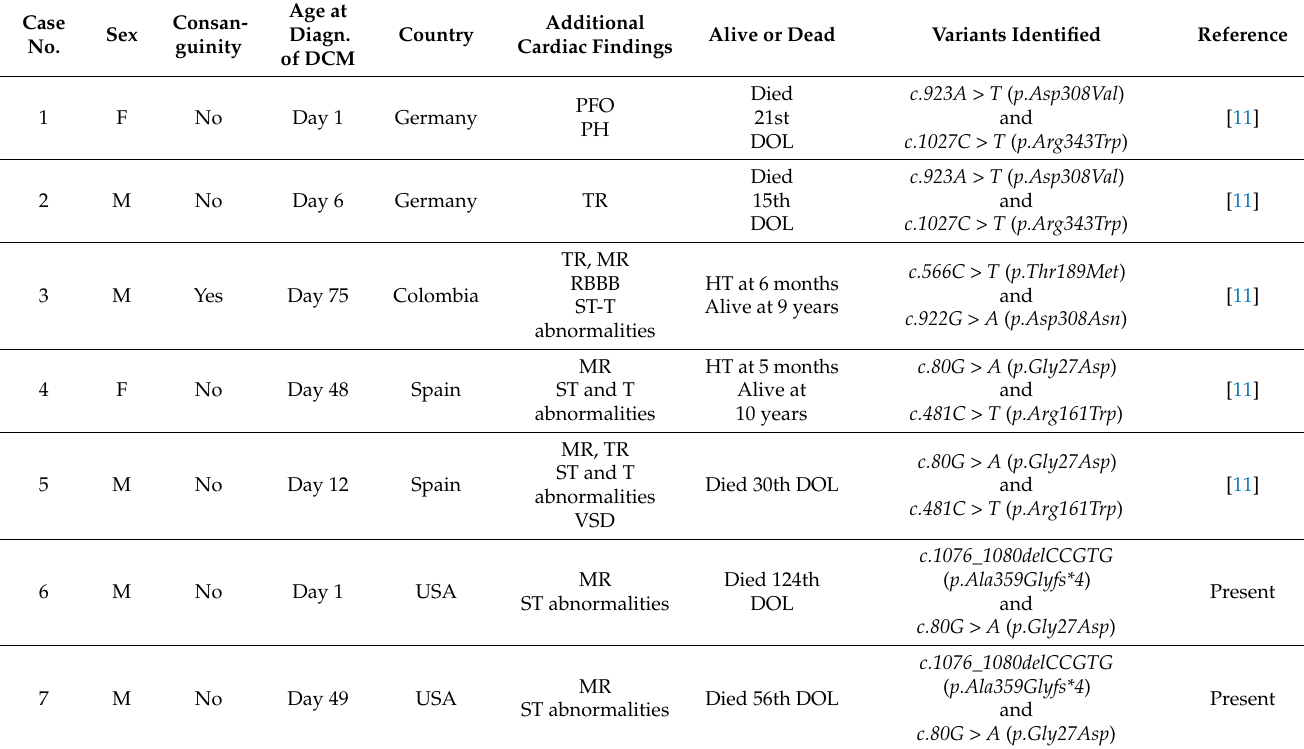
Table 1. Clinical and genetic findings in seven patients (including two present cases) with compound heterozygous variants of RPL3L diagnosed using WES and associated with the neonatal form of severe DCM reported in the